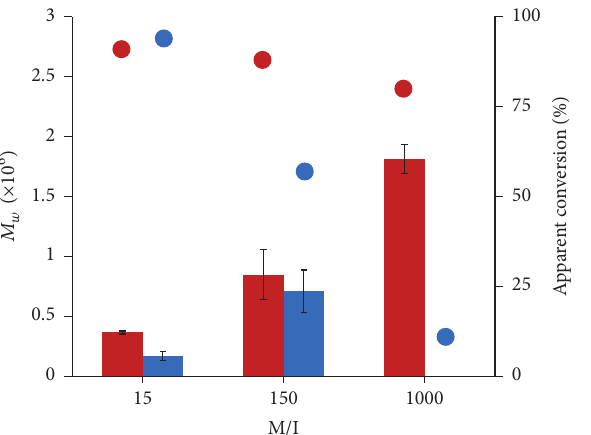
Figure 5: Weight-averaged molecular weight (bars) and apparent conversion (circles) for the deoxygenated admicellar polymeriza- tions of styrene initiated by (red color) AIBN and (blue color) V-501 at M/I values of 15, 150, and 1000. Table 2: Polymer weight lossof modified silica (in terms of